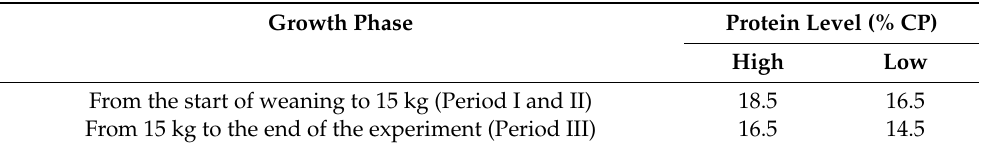
Table 2. Growth phases based on piglet body weight and overall crude protein percentage in the diet, depending on growth phase and protein